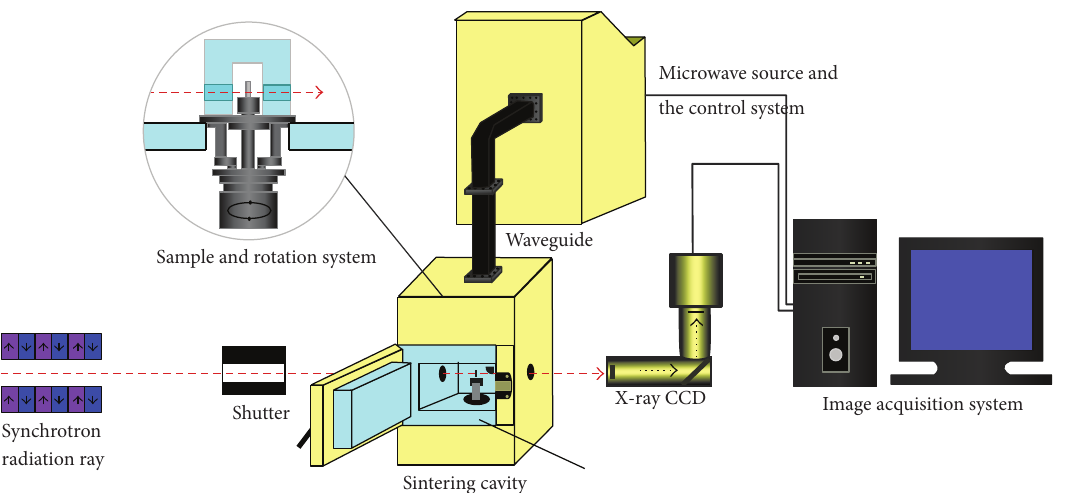
Figure 1: The schematic diagram of the SR-CT experiment system of microwave sintering.